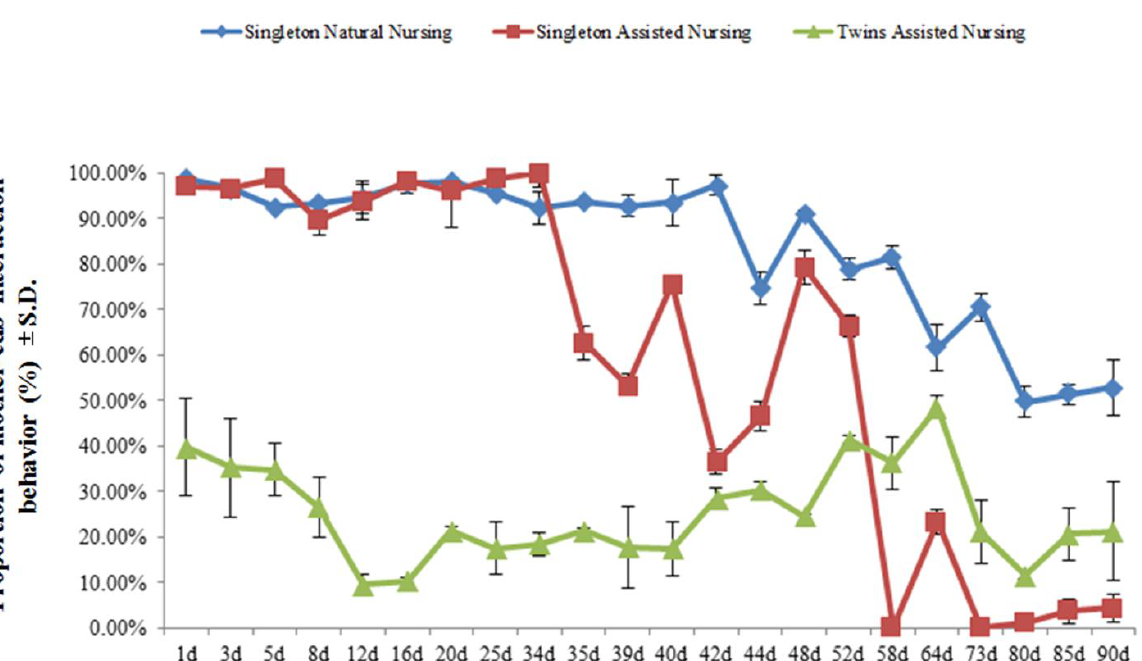
Figure 1. The percentage of time engaged in mother–cub interaction behavior during the early stage of the nursing period. Data were presented as mean ± S.D. (standard deviation). Mother–cub period: mother and cub together; mother-only period: the cub was removed and the mother was separated from her cub. Percentage of time engaged in mother–cub interaction behavior = time engaged in mother–cub period/(time engaged in mother–cub period ± time engaged in mother-only period) × 100%.